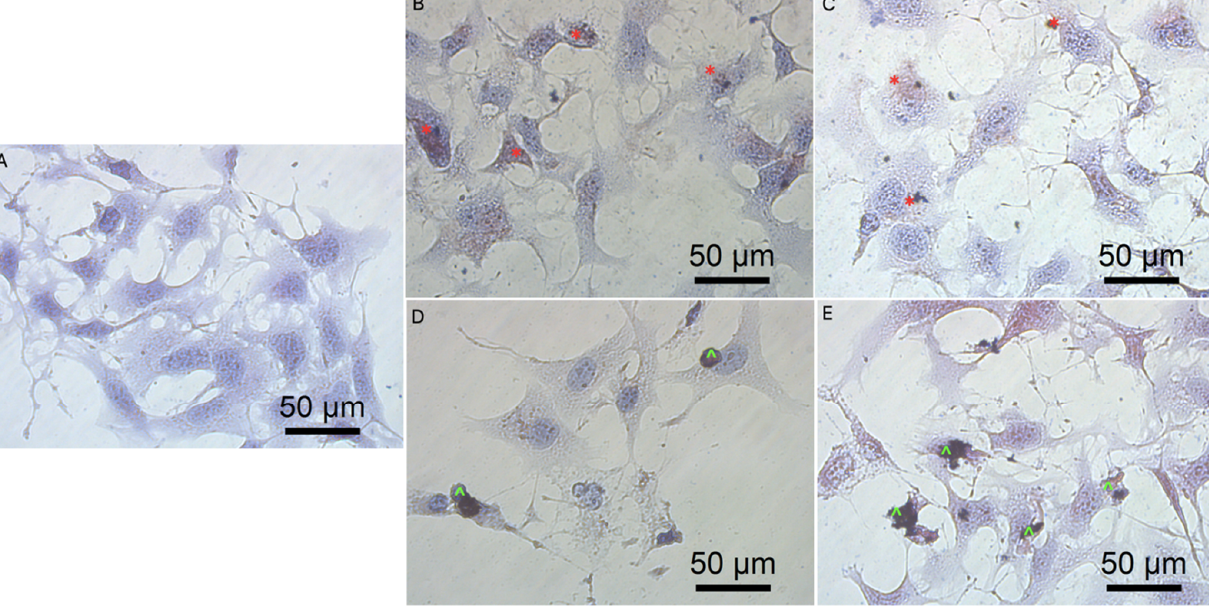
Figure 8. Morphology of T98 glioblastoma cells. ( A ) untreated cells (control group), cells treated with graphene oxide at concentration: 5 µg/mL ( B ), 100 µg/mL ( C ), and reduced graphene oxide at concentration: 5 µg/mL ( D ) and 100 µg/mL ( E ). Red * GO at cell membrane. Green ^ rGO at cell membrane. Light optical microscopy. Scale bars: 50 µm. ( A – E ). Abbreviations: GO: graphene oxide, rGO: reduced graphene oxide.